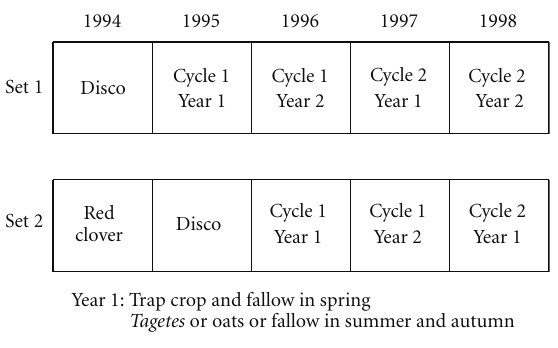
Figure 1: The two-year crop rotation scheme, representing the sequence of crops and treatments for one of three blocks. Each block was split into two “sets”: the experimental cycles in Set 1 started with the potato cultivar Disco in 1994. The experimental cycles of Set 2 started with the same potato cultivar in 1995, and red clover was grown in 1994. A cycle consisted of a sequence of crops and treatments lasting two years. Year one of a cycle consisted of two parts: spring treatments and treatments applied in summer plus autumn. Spring treatments were either fallow or the cultivation of a trap crop against potato cyst nematode. Summer/autumn treatments were one of three options: cultivation of Tagetes , oats, or fallow. In year 2 of the cycle, potatoes were grown on all plots; treatments consisting of three potato cultivars showed di ff ering degree of resistance to potato cyst nematodes (cvs Seresta, Karida, or Elkana); potato cultivar treatments were split up in two sub treatments consisting of incorporation or removal from the field of potato haulms. See Scholte [2] for more